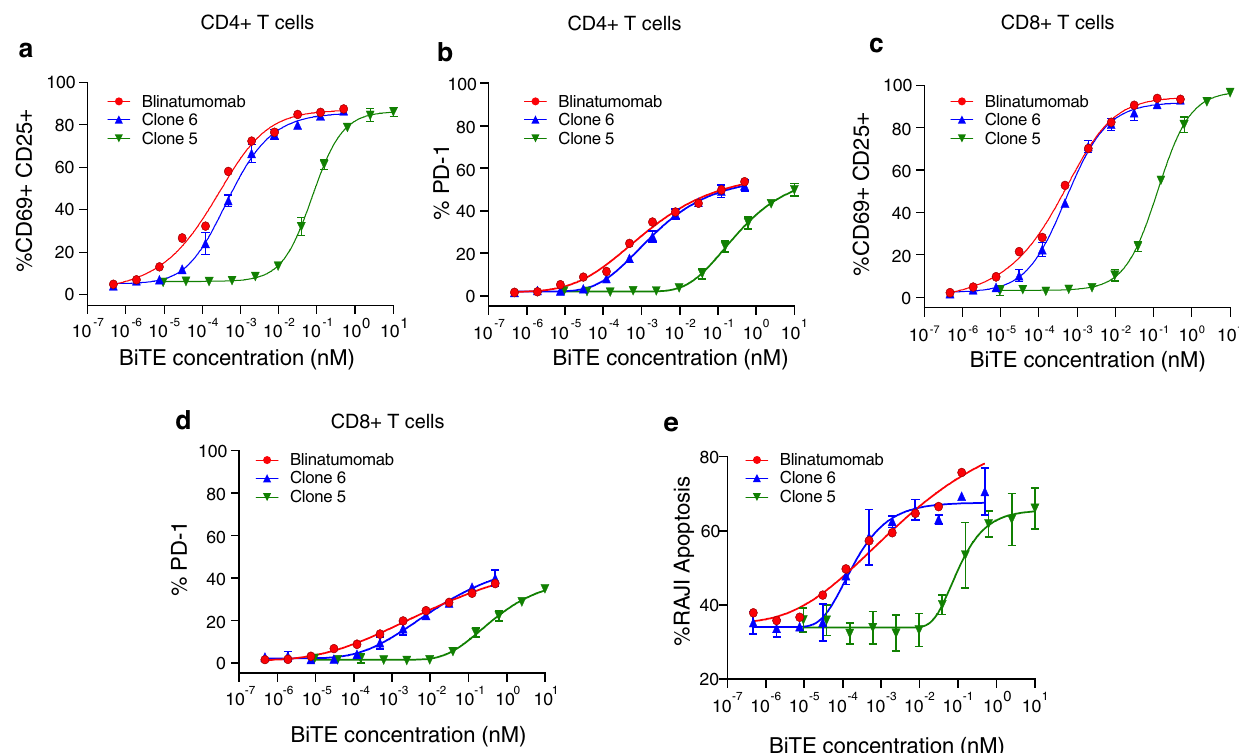
Fig. 6 Characterization of activity of puri fi ed Clone 5 and Clone 6 with primary T cells. a Activation pro fi le of CD4 + T cells (assessed by the percentage of double-positive CD69 + CD25 + population) in the presence of Raji cells and puri fi ed BiTE clones at varying concentrations. b Percentage of PD-1 expressing CD4 + T cells in the presence of Raji cells and puri fi ed BiTE clones at varying concentrations. c Activation pro fi le of CD8 + T cells (assessed by the percentage of double-positive CD69 + CD25 + population) in the presence of Raji cells and puri fi ed BiTE clones at varying concentrations. d Percentage PD-1 expressing CD8 + T cells in the presence of Raji cells and puri fi ed BiTE clones at varying concentrations. e Apoptosis of Raji cells in the presence of pan T cells (E:T = 10:1), isolated from donor PBMCs and puri fi ed BiTE clones at different concentrations assessed by Annexin V/7AAD staining of Raji cells. Data are presented as XY plots, and each data point is obtained as a mean of n ¼ 3 replicates (in the case of Clone 5 and Clone 6) for pan T cells isolated from n ¼ 1 donor PBMCs. Mean ± SD error bars are plotted for each data point. In the case of Blinatumomab, data is obtained from n ¼ 2 replicates, and error bars are not agarose gel image of PCR ampli fi ed product from cDNA of representative sorted droplets. We then expressed BiTE clones in a 1-mL scale Expi293F culture in a 96-well plate format. Two-